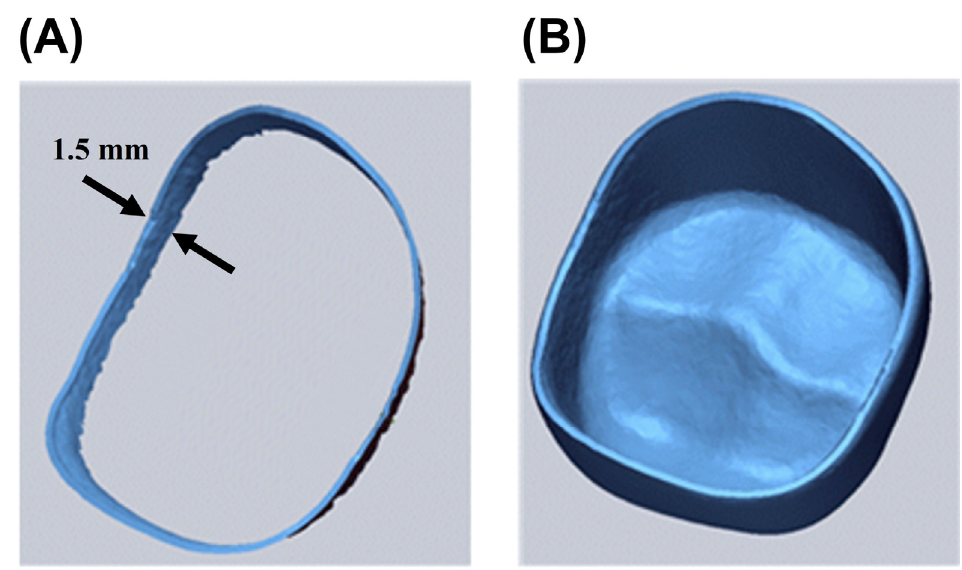
Figure 2. Images of ( A ) the marginal area and ( B ) the internal area obtained from the CAD reference data of the zirconia specimen.